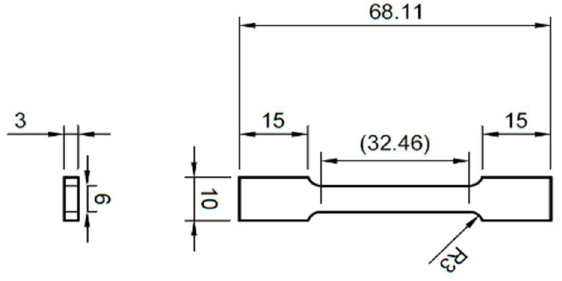
Figure 1. Schematic diagram for the tensile testing specimen. (Units are in mm).